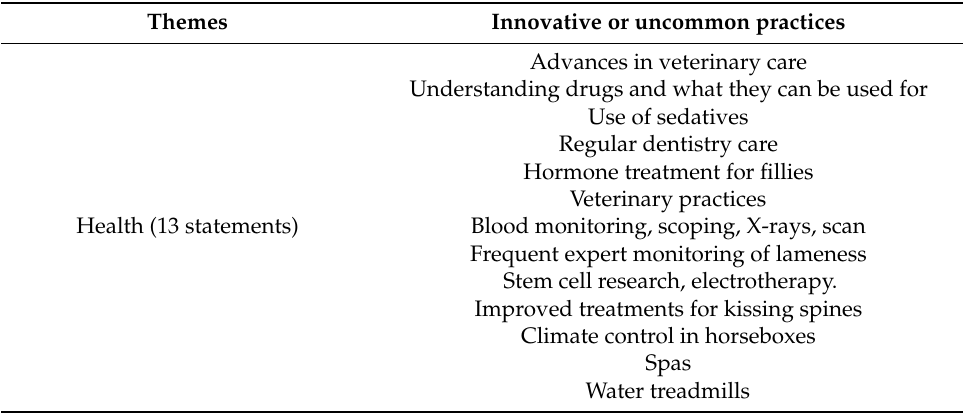
Table 3. Innovative or uncommon practices to improve welfare that stakeholders were aware of (27 statements in